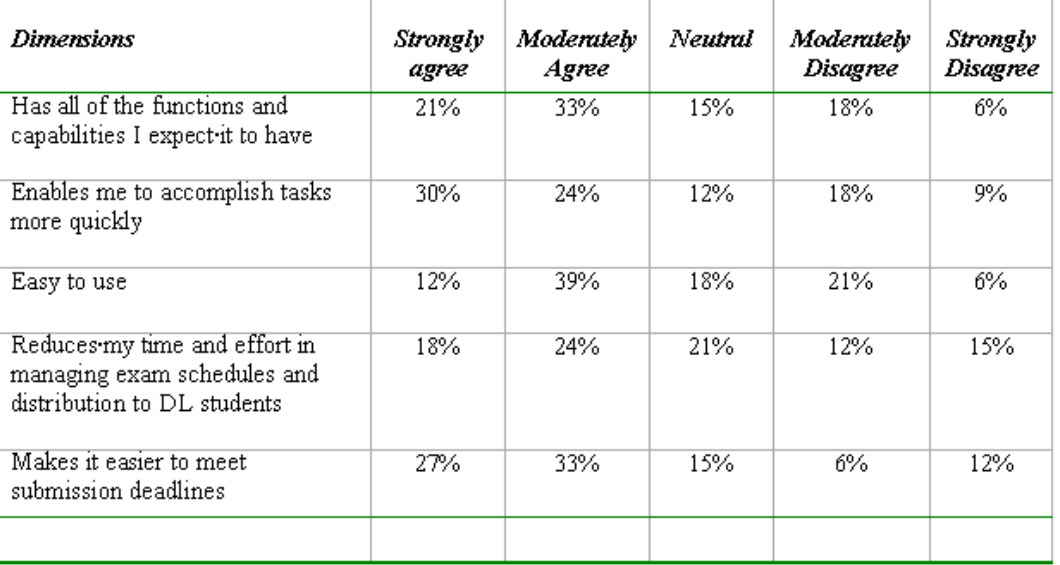
Table 1. Overall faculty satisfaction with the exam scheduling